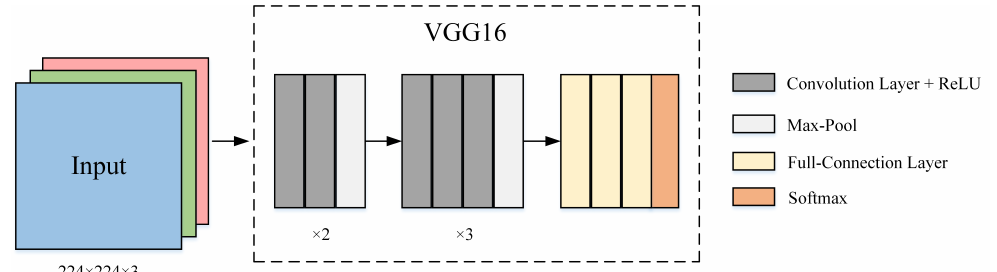
Figure 9. The architecture of the VGG-16 network. Conv: size = 3 × 3, stride = 1, padding = 1. Pool: size = 3 × 3, stride =